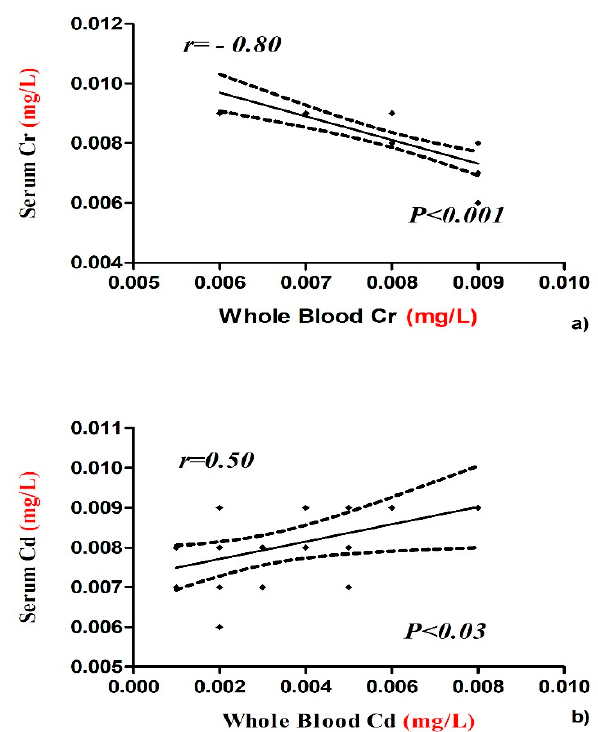
Figure 1. Negative correlation between whole blood and serum concentration of Cr ( a ) and positive correlation between whole blood and serum concentration of Cd ( b ) with Pearson’s correlation coefficients and significant values in horse.